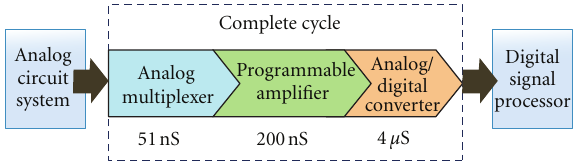
Figure 5: Conversion and completion